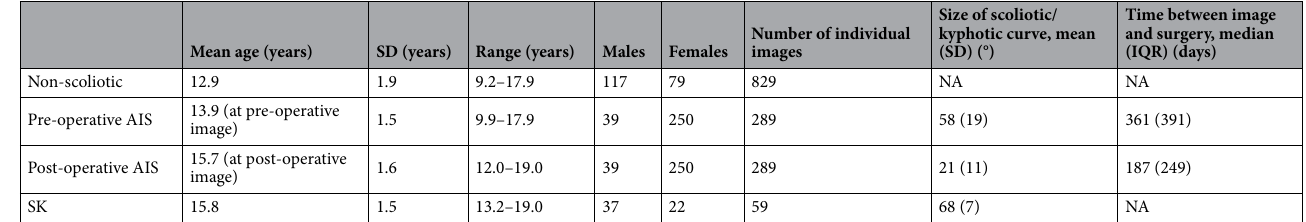
Table 1. The demographic details of the non-scoliotic, scoliotic and SK groups.